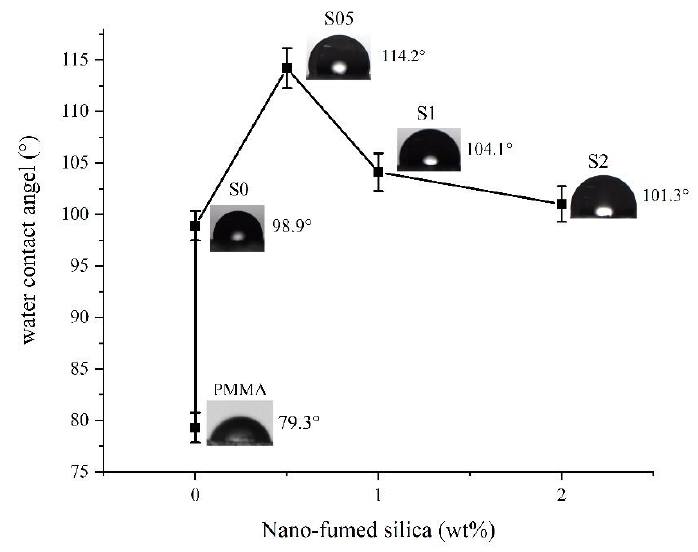
Figure 5. Water contact angles of samples with different nano SiO 2 particles.